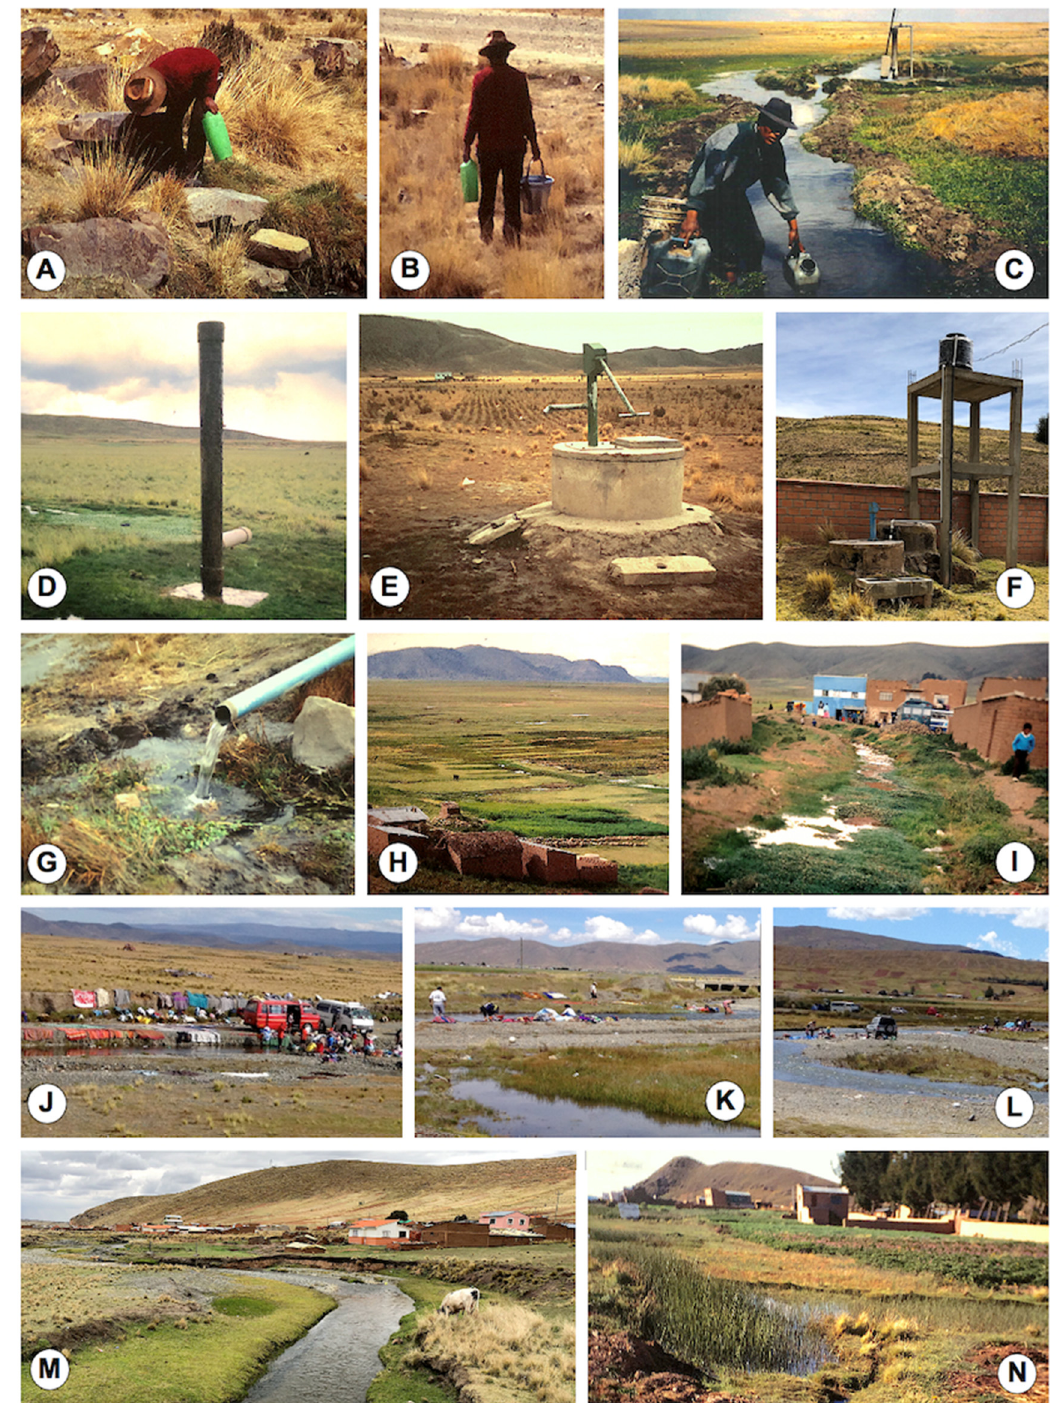
Figure 6. Natural water as fascioliasis infection source: ( A – C ) Freshwater is collected in the field to take home for food preparation, drinking and washing of kitchen utensils and clothes, sporadically for personal hygiene; ( D , E ) Lymnaeid snails usually colonize the flooded ground surrounding fountains as in Laja ( D ) and wells as in Chijipata Alto ( E ); ( F ) Motorized water availability is being recently installed in rural schools, as in Santa Rosa; ( G ) Water canalizations used for irrigation giving rise to habitats for lymnaeid vectors, in Chijipata Alto; ( H ) Reduced crops are only for local supply, in Cutusuma; ( I ) Floating metacercariae implying infection risk by water drinking were found in the small river inside the village of Tambillo; ( J , K ) Washing clothes is traditionally practiced in rivers inhabited by lymnaeid vectors, in Rio Karawisa: ( L ) Recreational activities are usually performed at wide lymnaeid-inhabited rivers by families with small children in weekends, in Batallas; ( M , N ) Closeness of freshwater collections is crucial in the decision of where to construct a dwelling, in San Calixto ( M ) and Copancara ( N ). ( A , B , D – N ) Photographs S. Mas-Coma; ( C ) Photograph J.G. Esteban. C modified from Mas-Coma et al., Parasitology, 2018, 145,